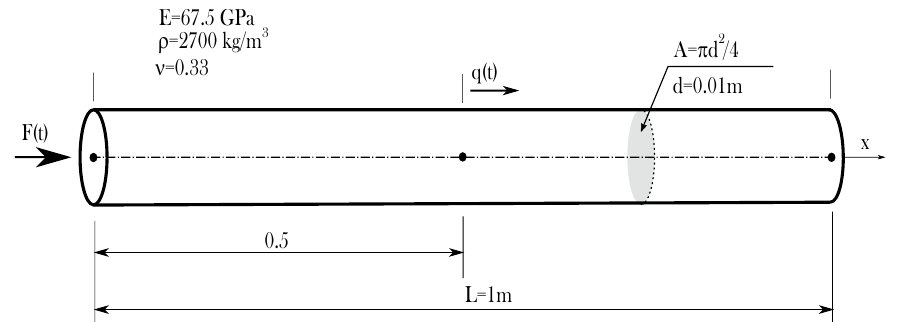
Figure 4. Exemplary rod element, no model dispersion, 161 degrees of